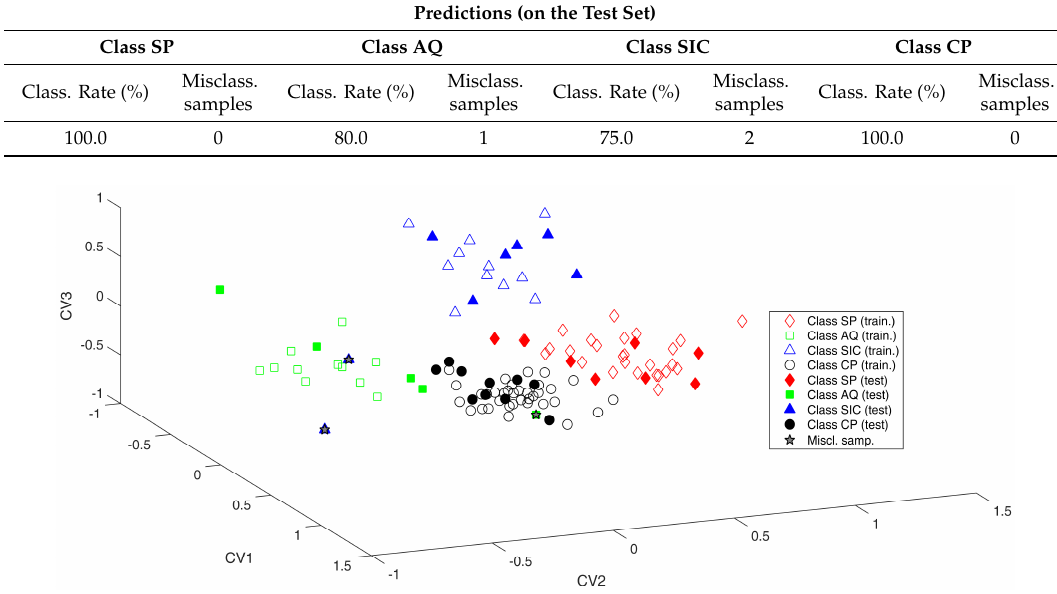
Table 2. Sequential and Orthogonalized Partial Least Squares Linear Discriminant Analysis (SO-PLS- LDA) analysis: External Validation. Correct classification rates (%) and number of misclassified test